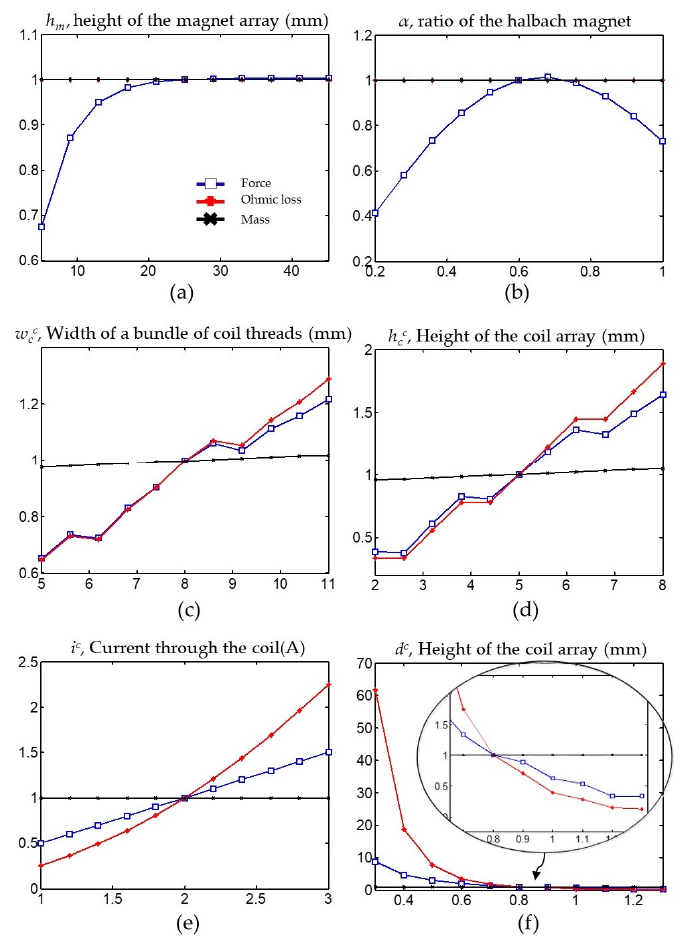
Figure 5. Results of the sensitivity analysis. ( a ) effect of height of the magnet array; ( b ) effect of the Halbach magnet ratio; ( c ) effect of bundle width of the coil; ( d ) effect of height of the coil array; ( e ) effect of electric current of the coil; ( f ) effect of height of the coil array.